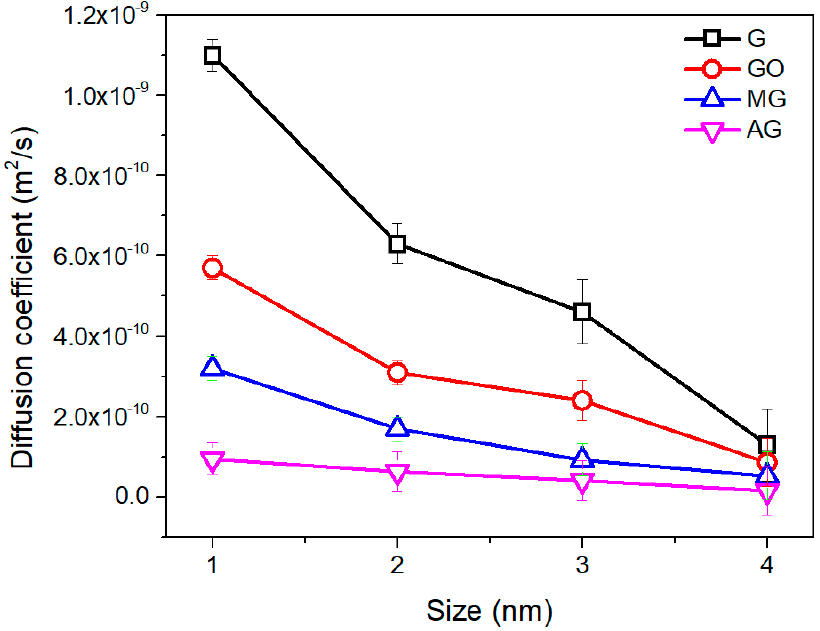
Figure 5. Diffusion coefficients of graphene with various functional groups calculated under NVT ensemble at 300 K and 0.1 MPa.